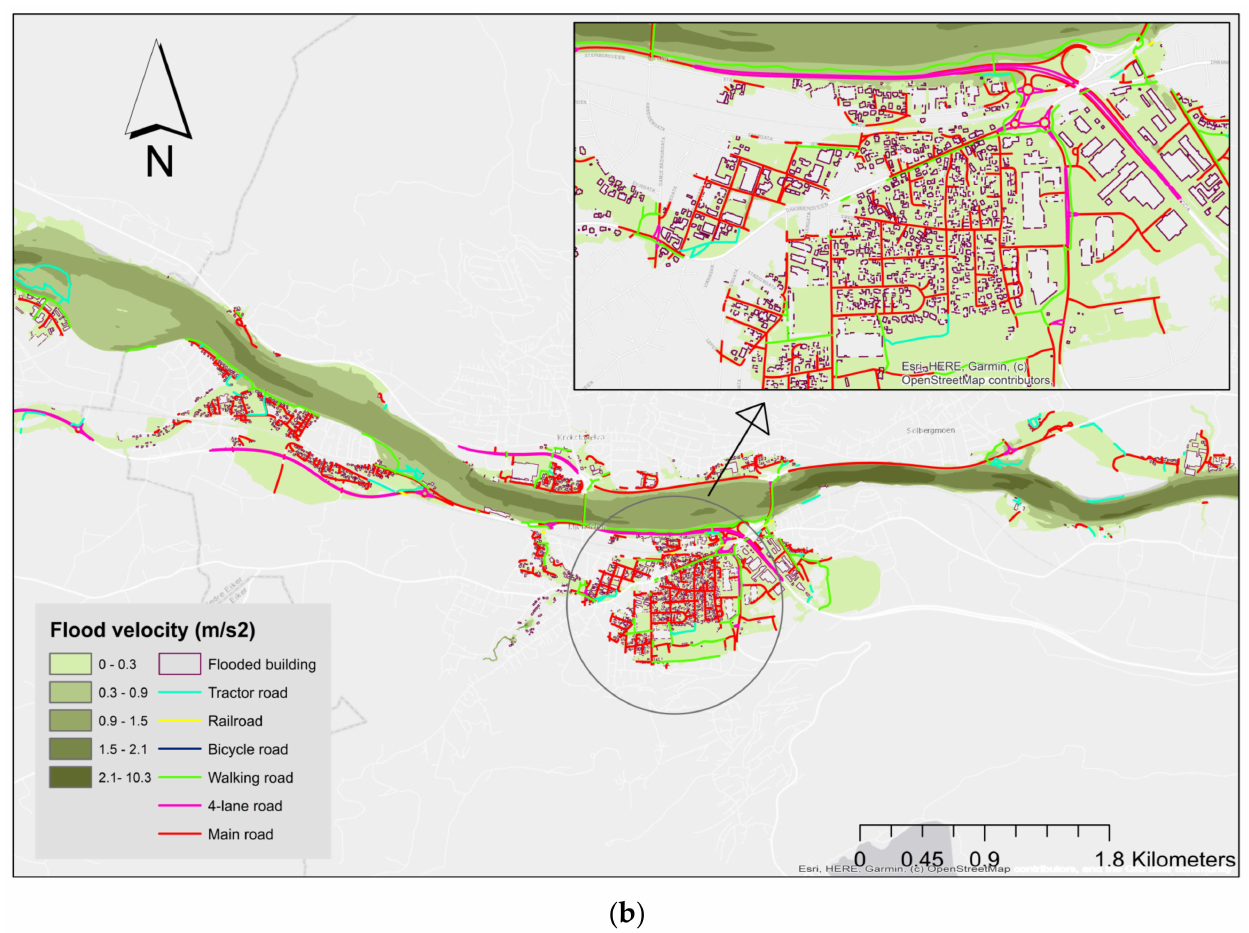
Figure 6. Flood velocities resulting from: ( a ) Q200 current climate flood scenario, and ( b ) Q200 future climate flood